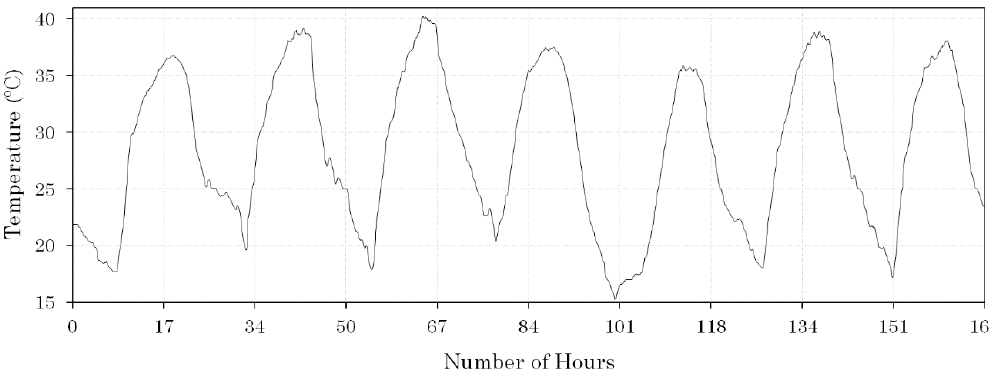
Figure 4. The verified outside temperature from 23 to 29 July for the city of Évora.